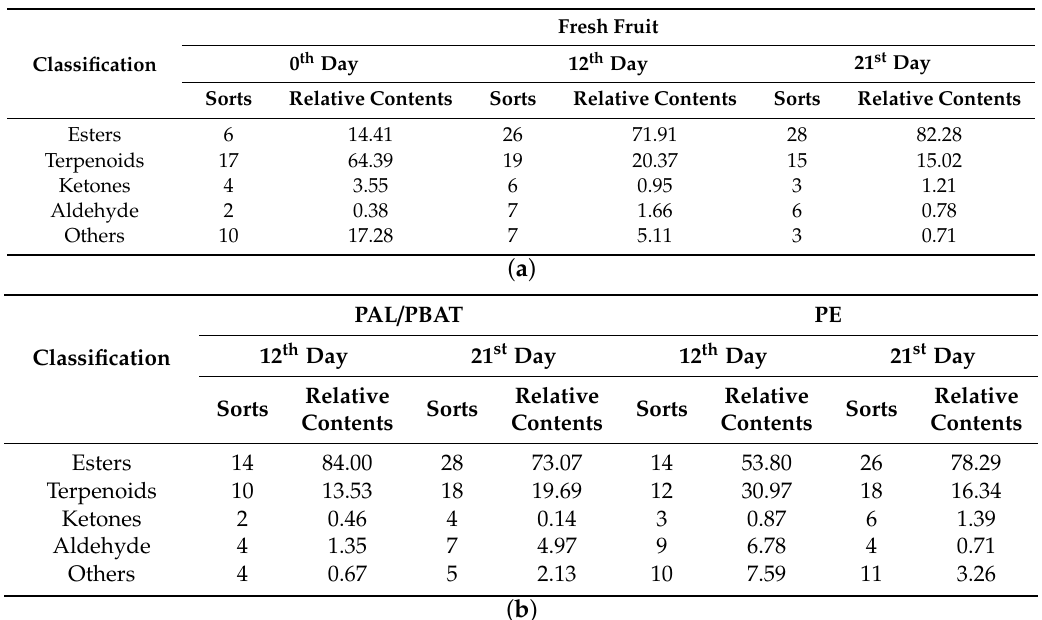
Table A2. E ff ect of PLA / PBAT antibacterial packaging film on the VOCs composition of passion fruit during storage times (t = 3); ( a ) Fresh fruit without packaged. ( b ) PLA / PBAT and PE